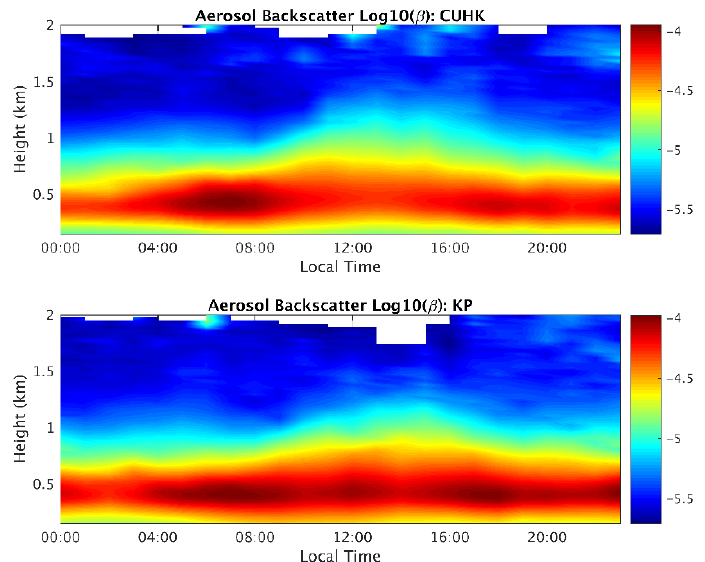
Figure 13. Mean aerosol backscatter log10(β) at CUHK (upper) and KP (lower) during the nine identified HPEs.